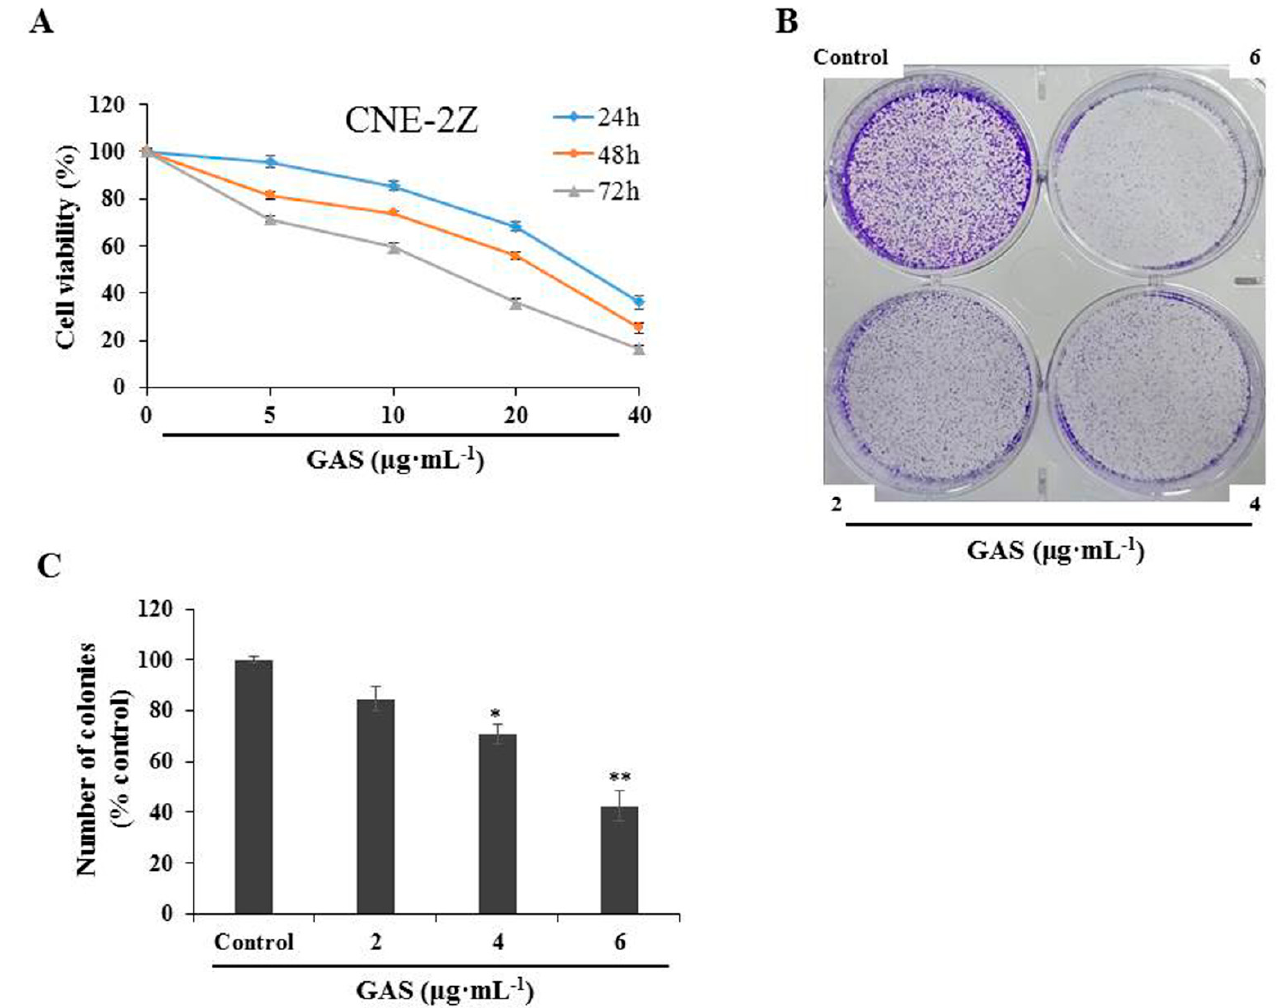
Figure 1. Inhibitory role of GAS on CNE-2Z cells. ( A ) CNE-2Z cells were treated with increasing concentrations (0, 5, 10, 20, and 40 μ g · mL − 1 ) of GAS for 24, 48, and 72 h. Cell viability was measured through an MTT assay. ( B ) The colony forming capability of CNE-2Z cells was measured using a colony formation assay after being treated with low concentrations (0, 2, 4, and 6 μ g · mL − 1 ) of GAS for 5 days. ( C ) Quantification of the colony-forming capability of CNE-2Z cells inhibited by GAS. * p < 0.05 and ** p < 0.01 compared with the control. Table 2. Anti-proliferative activities (IC 50 ) of GAS in four human cancer cells.